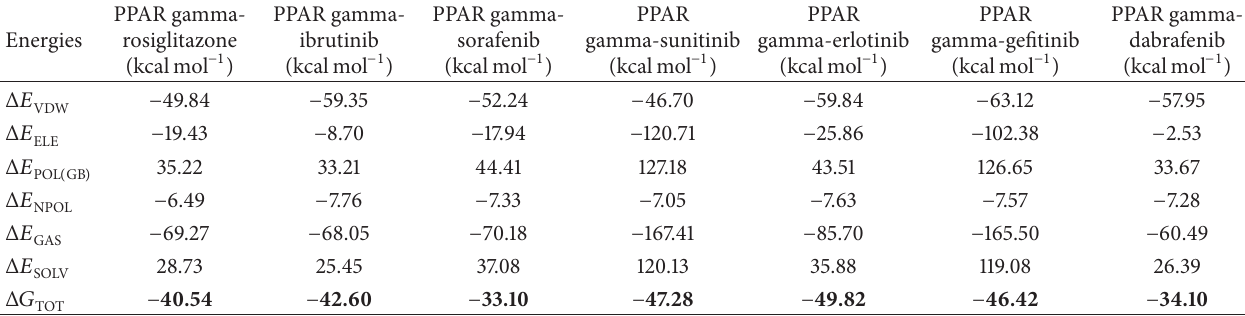
Table 2: Calculated total binding energies for PPAR gamma-TKI’s and PPAR gamma-rosiglitazone complexes by MM-GBSA. Energies